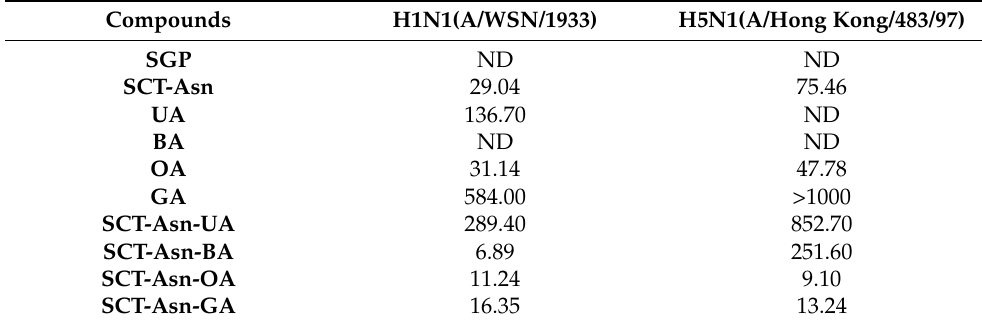
The thermodynamic dissociation constant K D ( µ M) values of compounds